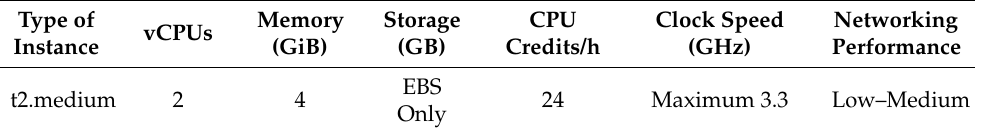
Table 6. Specifications of the instance for AWS [19–21].